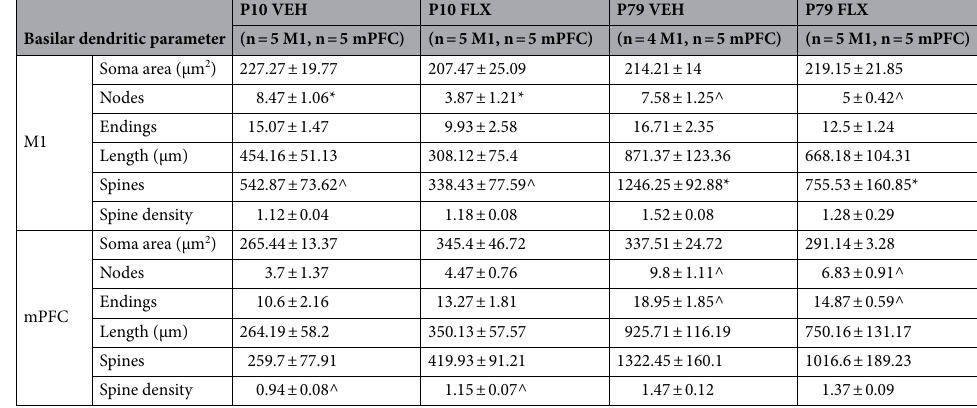
Table 3. Morphometric feature summary of layer V pyramidal neurons. Results are mean ± SEM. * p < .05, ^ p < .10.